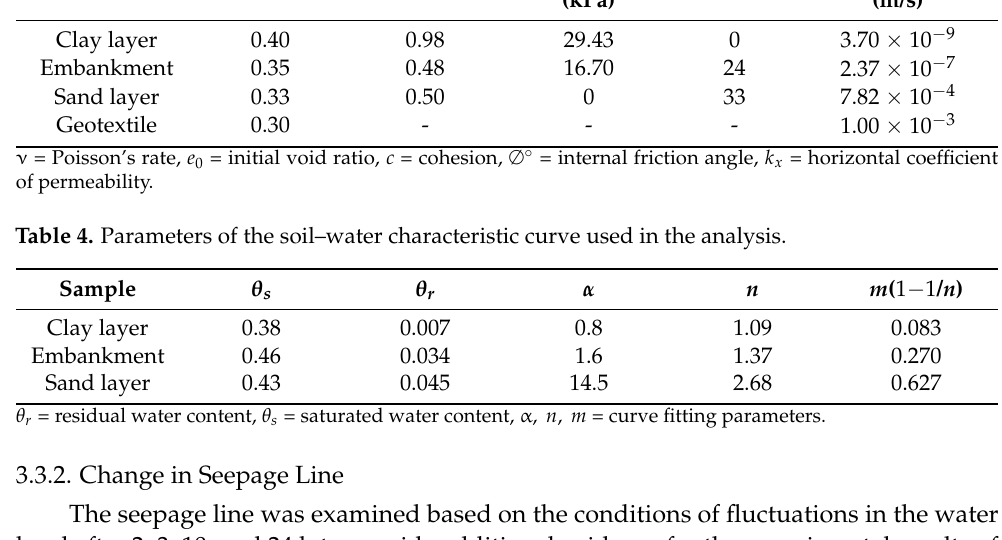
Table 3. Parameters used in analysis. Sample